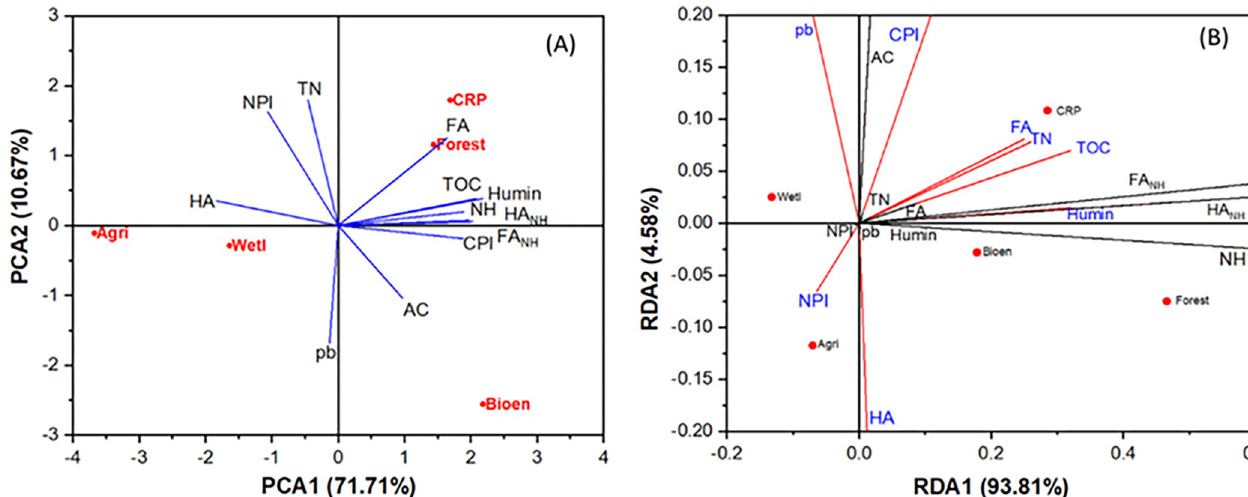
Fig 8. Principal components analysis (a) and redundancy analysis (RDA) on 12 soil parameters as influenced by land-use management systems [Agri: Agriculture; Bioen: Bioenergy; CRP: Conservation Research program; and Forest, Wetl: Wetland]. Soil parameters: AC is active carbon, CPI is carbon pool index, FA is fulvic acid, FANH is fulvic acid associated non-humic carbon, HA is humic acid, HANH is humic acid associated non-humic carbon, NH is glucose equivalent non-humic carbon, NPI is nitrogen pool index, ρ b is soil bulk density, and TN is total nitrogen.